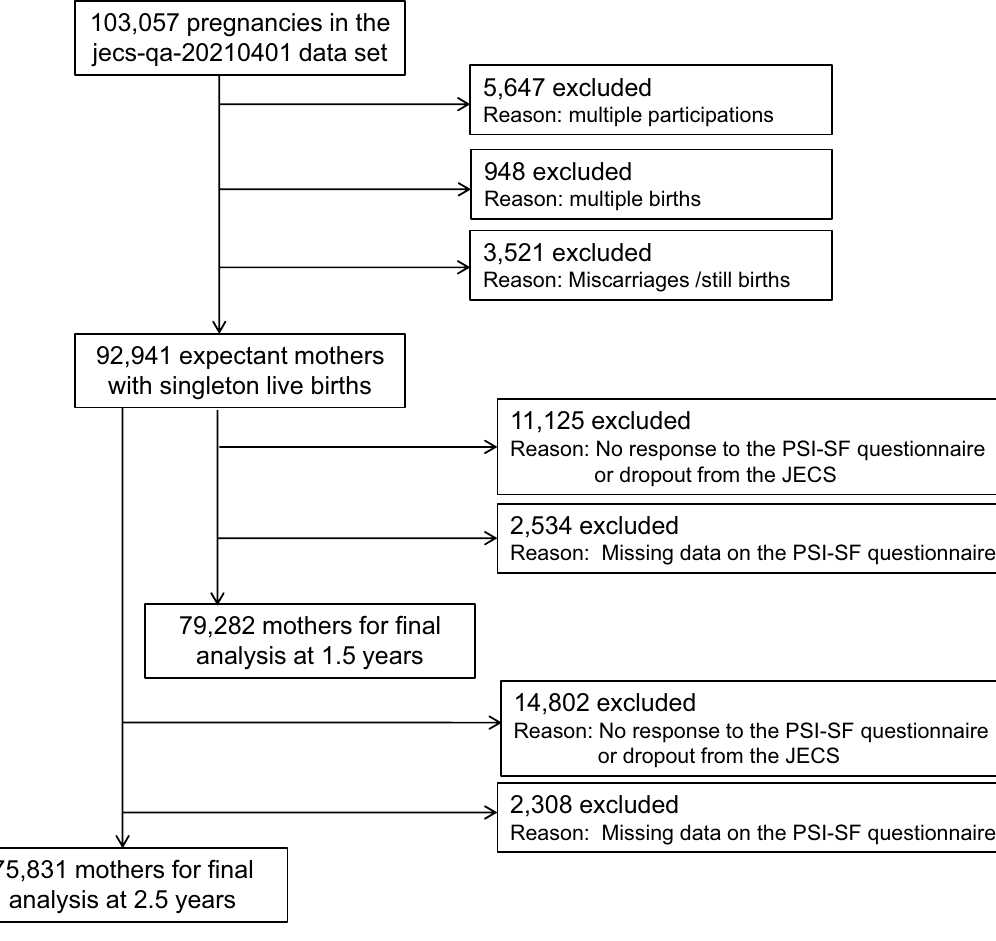
Figure 1. Flow diagram of the